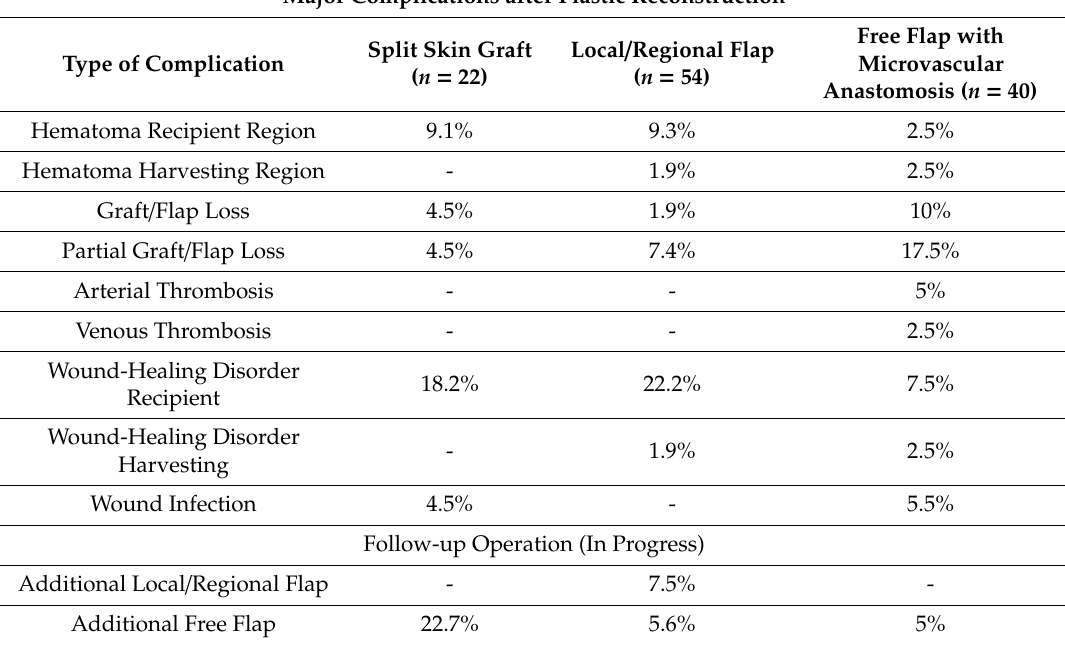
Table 6. Analysis of the type of major complication.